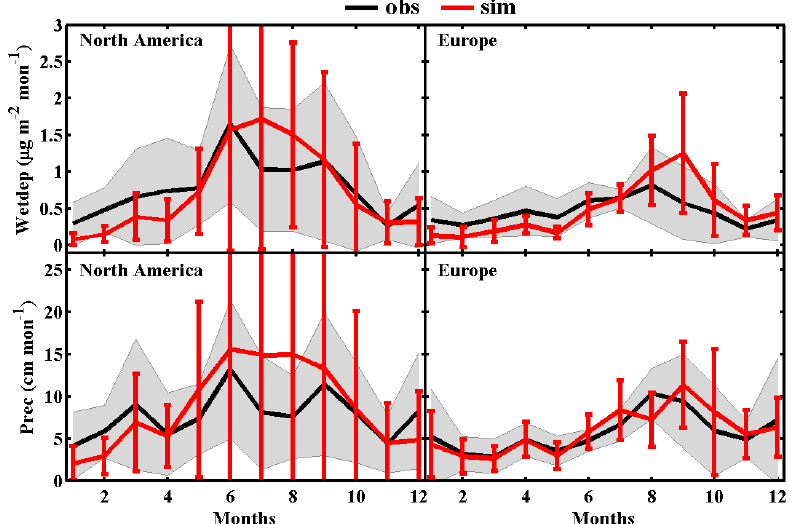
Figure 8. Mean seasonal variation of mercury wet deposition (µgm − 2 mon − 1 ) and accumulated precipitation (cmmon − 1 ) at North America (51 sites averaged) and Europe (8 sites averaged) sites in 2001. Gray shaded areas and red vertical bars show 1 standard deviation over the sites for observations and for model